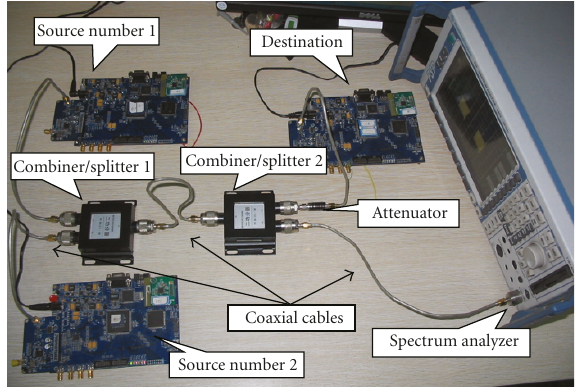
Figure 9: Experiment setup for the proposed method.